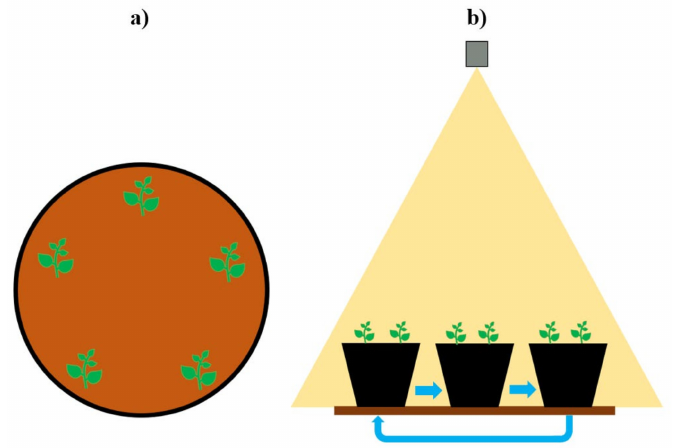
Figure 1. ( a ) Scheme of seedlings distribution in a single pot; ( b ) scheme of pots position under the same light conditions.